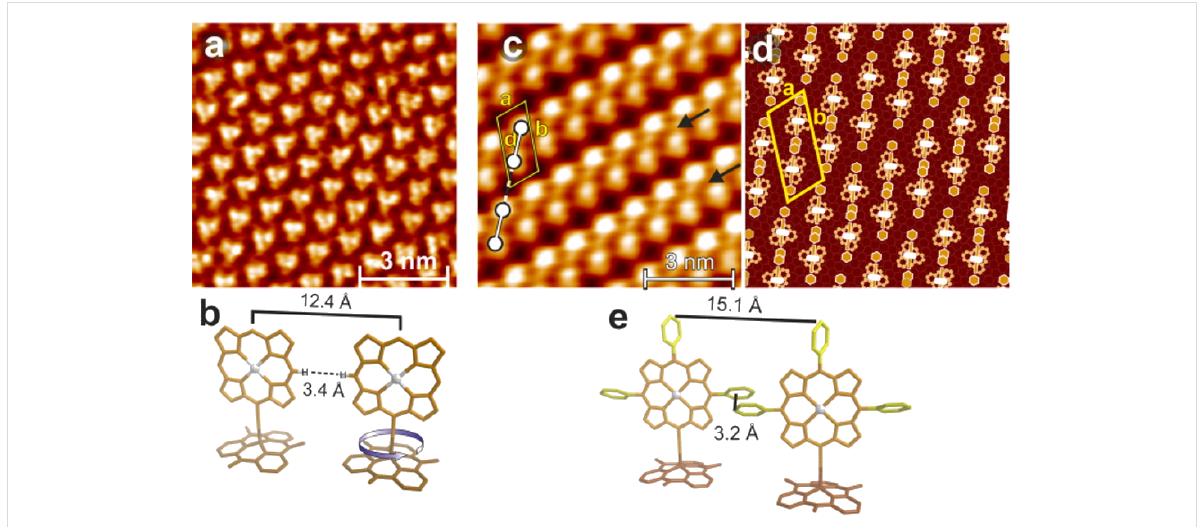
Figure 31: (a) STM image of a porphyrin–TATA adlayer of a zinc-porphyrin derivative of the octyl-TATA platform 54 (R''' = H) on Au(111) ( I t = 9 pA, U Bias = 0.5 V). (b) DFT (PBE/SVP-D2) calculated structure of two neighboring molecules of 54 (R''' = H). The following restraints were applied: dis- tance between neighboring molecules 12.4 Å (taken from STM); only the first four CH 2 groups of the octyl chains are optimized; all platform nitrogen atoms are in a plane (constraint of the surface); orientation of porphyrins is parallel (barrier of rotation is 0.3 kcal·mol − 1 ); all other geometry parame- ters are optimized. (c) STM image of a triphenylporphyrin-TATA adlayer of 54 (R''' = Ph) on Au(111) ( I t = 13 pA, U Bias = 0.48 V). (d) Structural model of the adlayer. In the unit cell (indicated by the rhombus), there are two molecules separated by a lateral distance d = 15.1 Å. (e) DFT (PBE/SVP-D2) calculated structure of two neighboring molecules of 54 (R''' = Ph), at a fixed intermolecular distance of 15.1 Å (for further restraints, see (b)). Reprinted with permission from [145], copyright 2014 American Chemical